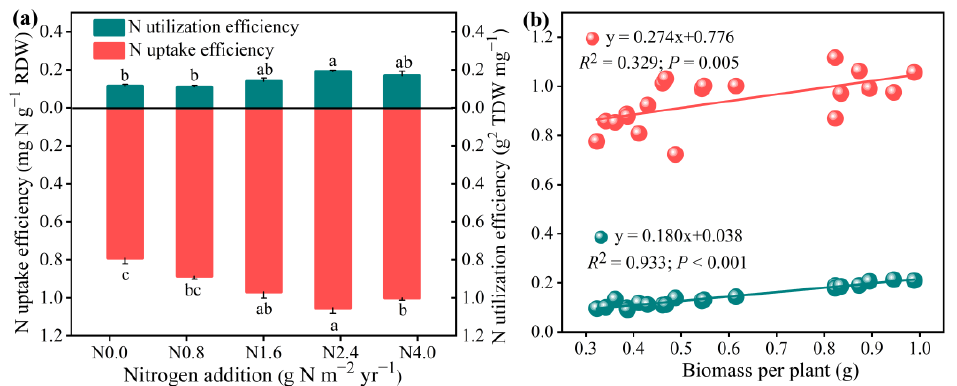
Figure 5. Effects of N addition on N uptake efficiency (NUpE) and N utilization efficiency (NUtE) of A. mongolicum ( a ), and the relationship between the NUpE and NUtE and the total biomass ( b ). Values are the mean ± standard error ( n = 4). Different letters above bars indicate significances among the N addition treatments ( p < 0.05).